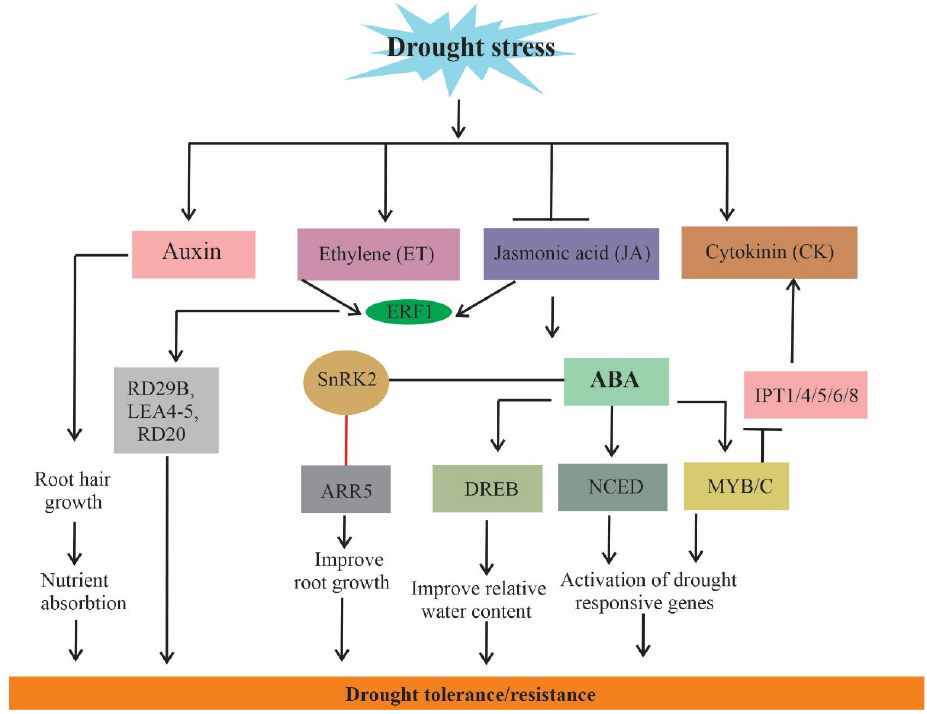
Figure 4. Proposed model of auxin, ethylene (ET), jasmonic acid (JA), cytokinin (CK), and ABA